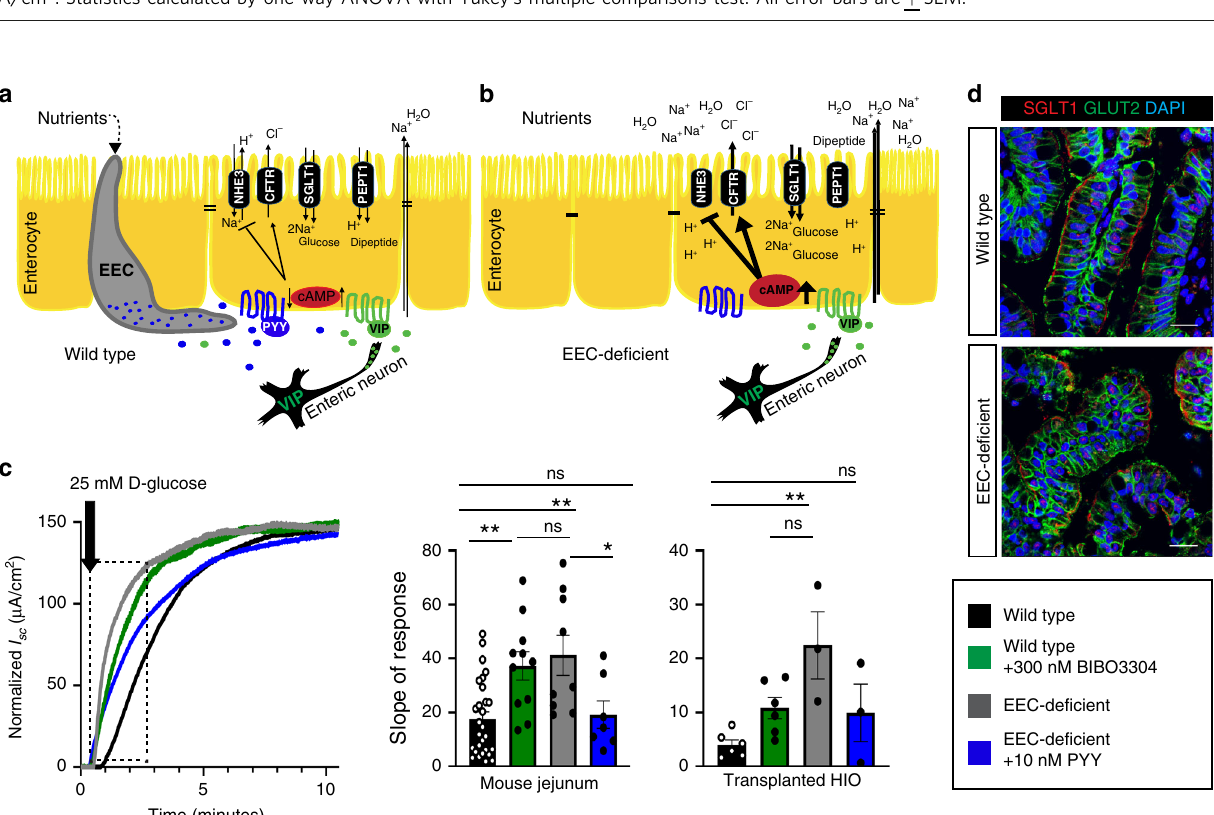
Fig. 2 PYY restores normal glucose absorption in EEC-de fi cient human and mouse small intestine. a Schematic depicting how the PYY-VIP paracrine axis might regulate ion, water, and nutrient transport in the small intestine. b In the absence of EECs, ion, water, and nutrient transport are dysregulated due to loss of one arm of the PYY-VIP axis. In EEC-de fi cient small intestine, loss of PYY results in increased chloride transport and increased water and sodium accumulation in the intestinal lumen. Reduced NHE3 transport activity would cause accumulation of cytosolic H + and a decrease in pH. Subsequently, nutrient absorption would be dysregulated, with diminished di-/tri-peptide absorption due to increased intracellular proton accumulation and increased uptake of glucose due to an exaggerated Na + gradient across the apical membrane. c Na + -coupled glucose transport is deranged in EEC- de fi cient human and mouse small intestine. Wild-type and EEC-de fi cient human and mouse intestinal tissues were treated with VIP prior to 25 mM D- glucose. EEC-de fi cient intestine had an elevated initial response to glucose (mouse, n = 28 wild-type, n = 9 mutant, ** P = 0.001; HIO, n = 6 wild-type, n = 4 mutant, ** P = 0.002) that was returned to wild-type levels by pre-treatment with 10 nM exogenous PYY (mouse, n = 7, * P = 0.04; HIO, n = 3). Inhibition of NPY1R in wild-type tissues using BIBO3304 caused an abnormal initial response to glucose that mimicked EEC-de fi cient tissues (mouse, n = 12, ** P = 0.005; HIO, n = 6). Bar graphs represent the slope of the curve depicted within the boxed area. Statistics calculated by one-way ANOVA with Tukey ’ s multiple comparisons test. d The subcellular distribution of glucose transporters SGLT1 and GLUT2 is normal in human intestinal tissue lacking EECs. Representative images from eight independent organoids are shown. Scale bars = 50 μ m. All error bars are +